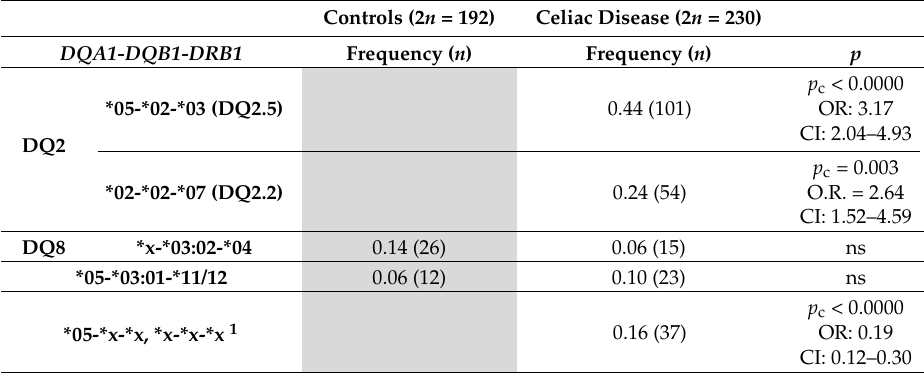
Table 2. Distribution of the HLA-DQA1-DQB1-DRB1 haplotypes in CD in Moroccans. Controls (2 n = 192)